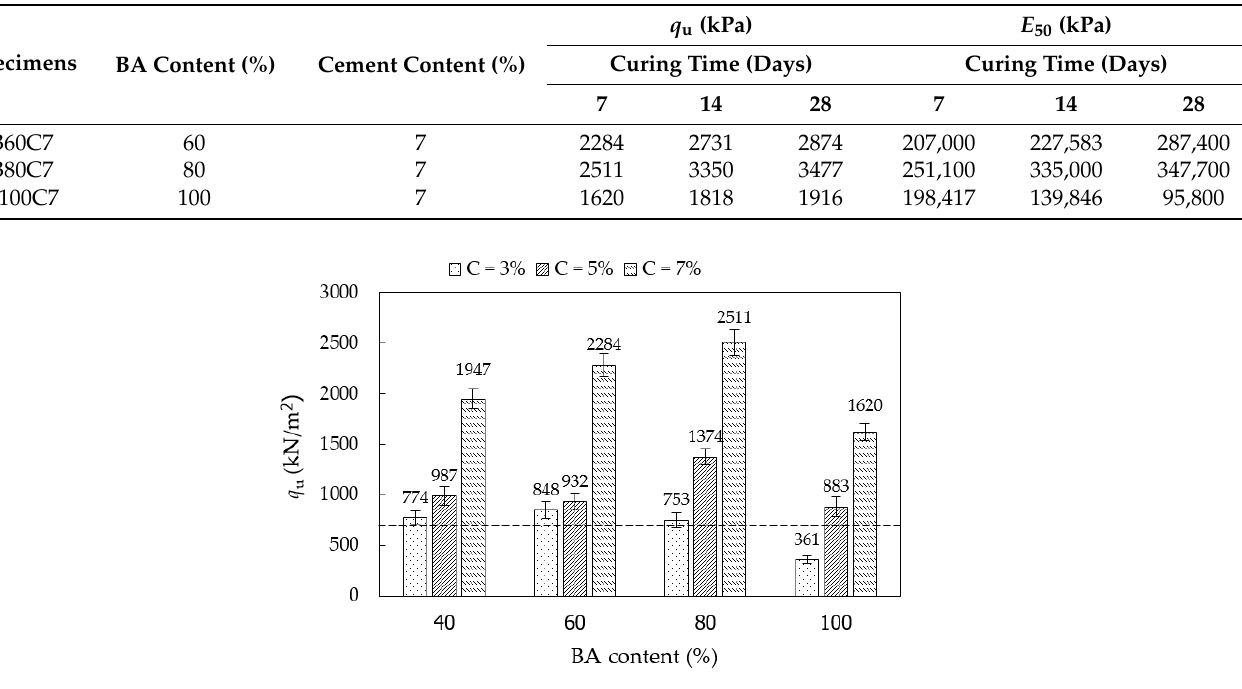
( c ) Figure 8. Strength development with the curing time of the CSS: ( a ) cement = 3%; ( b ) cement = 5%; ( c ) cement = 7%. Table 4. q u and E 50 of the CSS specimens with different curing times. Specimens